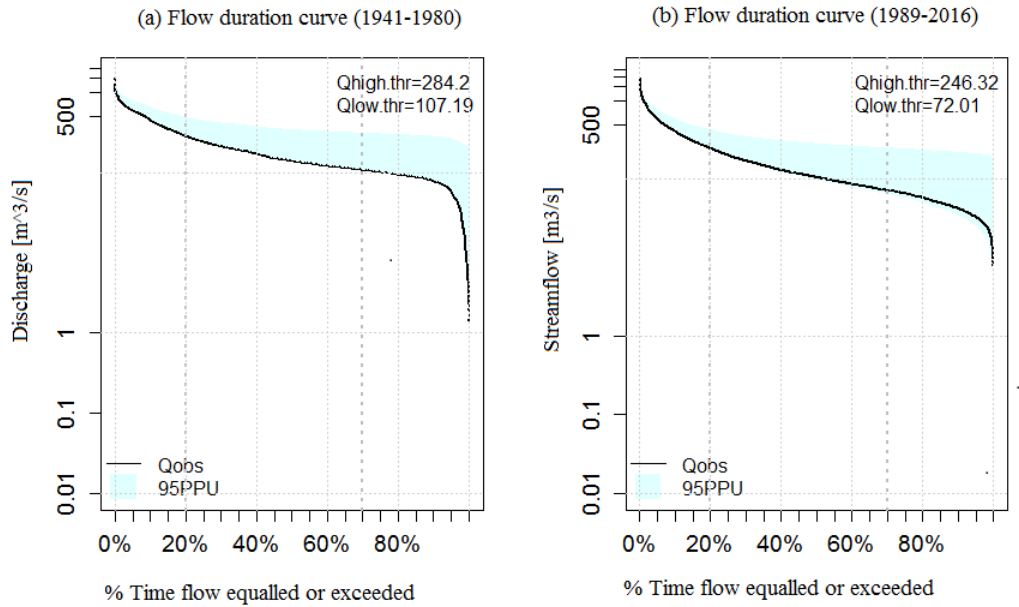
Figure 5 . Flow Duration Curve of Tana River, comparing 1941–1980 and 1989–2016 periods showing observed streamflows (Qobs) for two uncertainty bounds (95PPU being upper bound at 95% confidence level) .